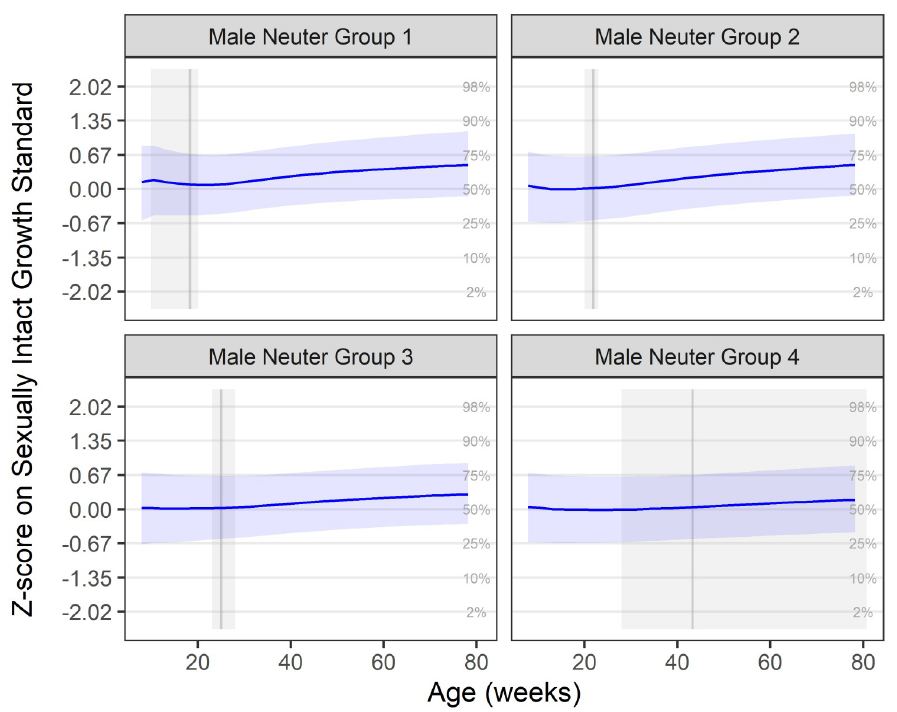
Fig 1. Median male growth trajectory by neuter group on z-score scale. Neuter Groups 1–4 represent, respectively, neutering ages of up to 20 weeks (0.7k cats), 20–23 weeks (2.1k cats), 23–28 weeks (2.5k cats) and > 28 weeks (3.0k cats). Groups calculated from the lower quartile, median and upper quartile of ages at all neutering procedures performed on DSH cats between April 1994 and November 2016. The solid blue line represents the mean trajectory, whilst the blue-shaded ribbon represents the interquartile range. The grey shaded area represents the neutering age range for the group, and the solid grey vertical line shows the median observed neutering age. Grid lines represent the standard growth centiles, such that a growth trajectory following the centile curves would be horizonal in these plots. In all groups, there was an upwards inclination in growth trajectory, which was most marked in neuter groups 1 and 2.